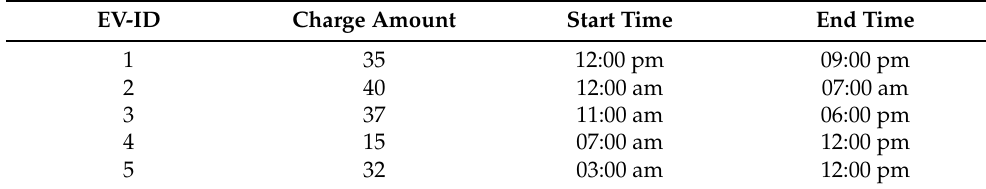
Table 4. EV sample data (preferred charging amount and period).